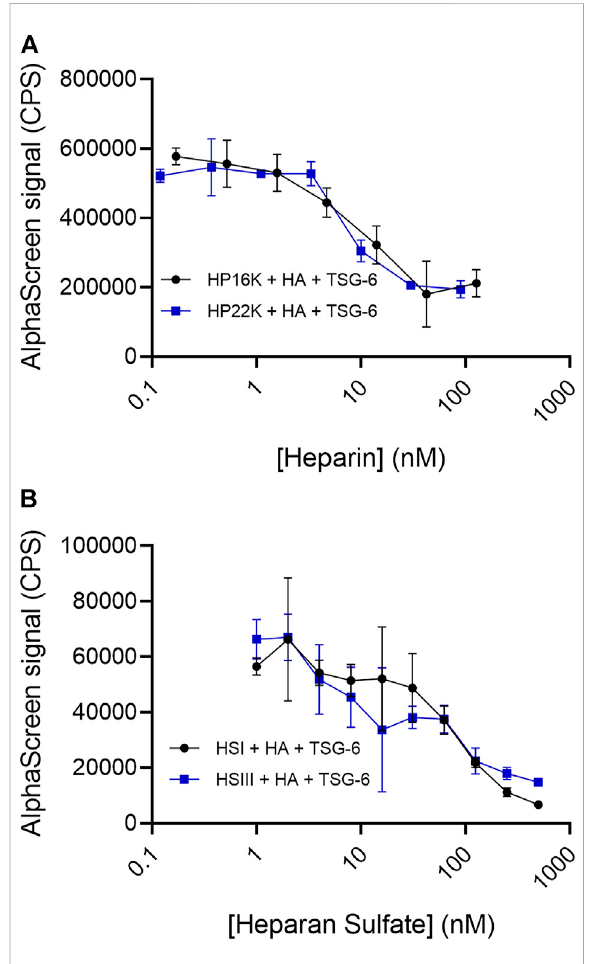
FIGURE 6 (A) Heparin and (B) Heparan sulfate compete with HA for binding to TSG-6. In the AlphaScreen experiments, end- biotinylated HA at 0.2 nM fi nal chain concentration was incubated together with TSG-6 protein at 14 nM fi nal concentration, and increasing concentrations of heparin (HP) or heparan sulfate (HS) in free solution, then mixed with streptavidin-coated donor and nickel chelate-coated acceptor beads for detection of HA- TSG-6 direct binding. Signal was recorded as counts per second (CPS). Each experiment was repeated at least three independent times, and a representative experiment is shown. Each data point represents the mean ± standard deviation from triplicate wells.